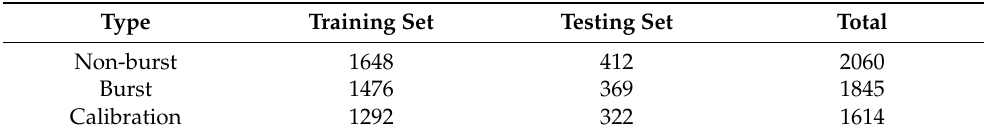
Table 1. Number of solar radio spectrum samples. Type Training Set Testing Set Total